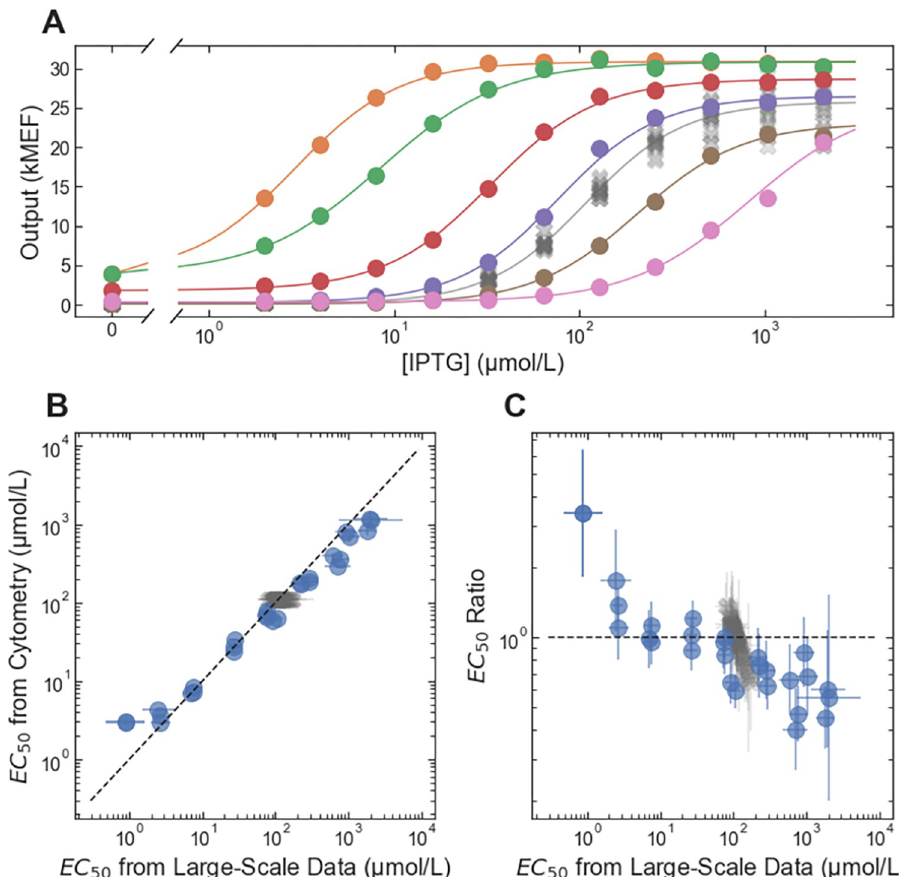
Fig 2. Accuracy and precision of EC 50 from in silico selection. (A) Example dose-response curves for LacI variants selected to span a wide range of EC 50 values. Each variant is plotted with a different color, with lines showing the fits to the dose-response using the Hill equation. The wild-type dose response is plotted with the gray ‘X’ markers. (B) EC 50 from the flow cytometry measurements plotted vs. EC 50 from the large-scale dataset. The dashed line indicates equality between the cytometry and large-scale results. (C) The ratio: ( EC 50 from flow cytometry) � ( EC 50 from the large-scale dataset) plotted vs. EC 50 from the large-scale dataset. In both B and C, results for non-wild-type LacI variants are plotted with blue circles, and results for wild-type LacI are plotted with gray X’s (there were multiple copies of the wild- type in the large-scale dataset, each plotted separately). Error bars indicate ± one standard deviation.